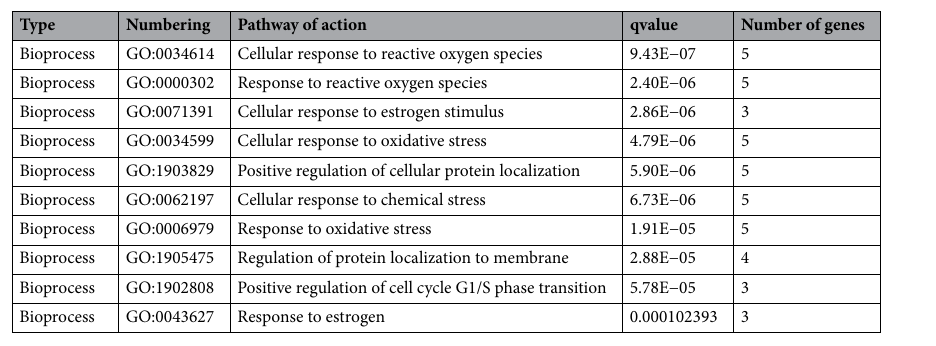
Table 1. GO enrichment analysis of core